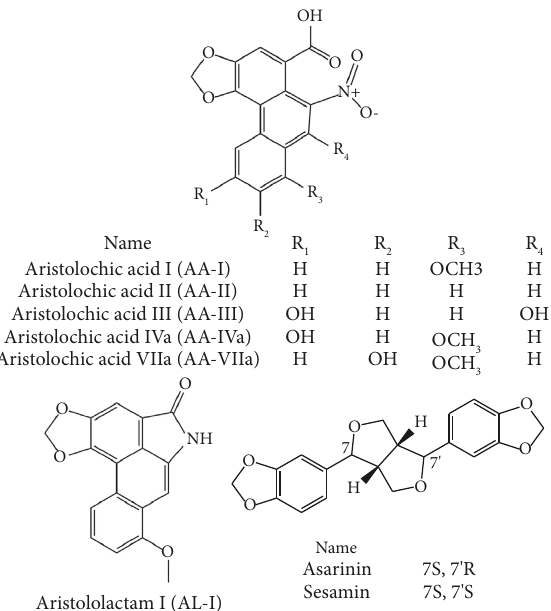
Figure 1: Chemical structures of analytes in this